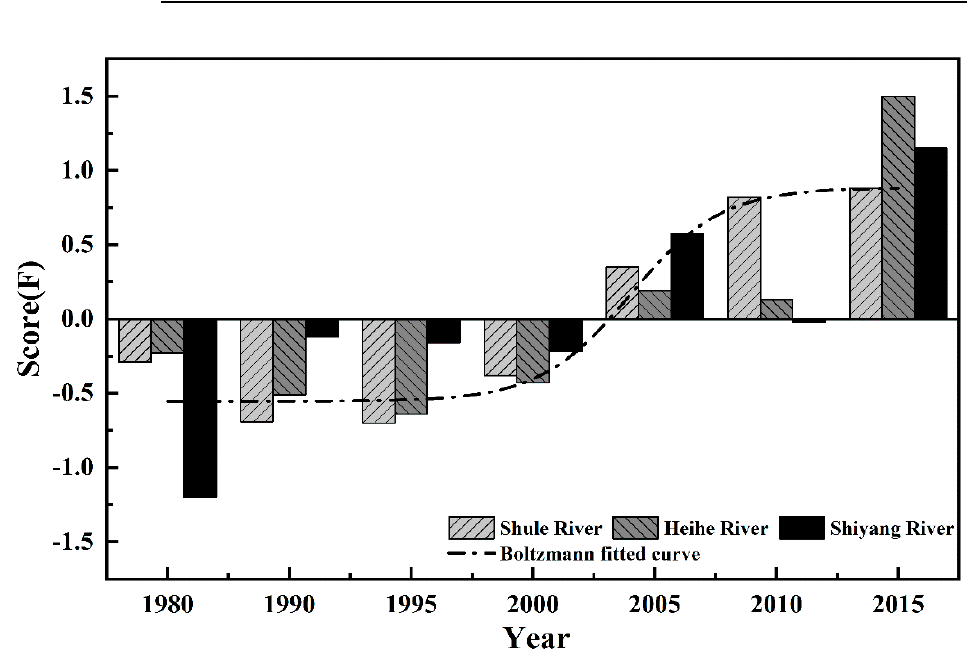
Figure 7. The trend of the driving forces score of the base flow change in Hexi inland rivers basin from 1980 to 2015.